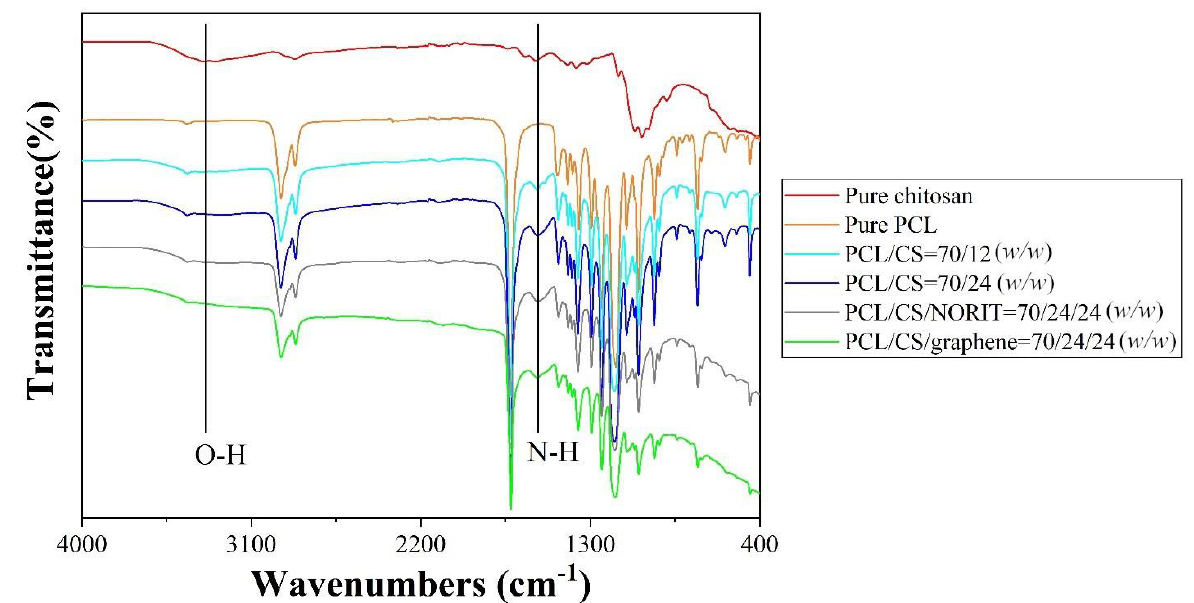
Figure 6. The FTIR spectra of the PCL/CS porous monoliths.